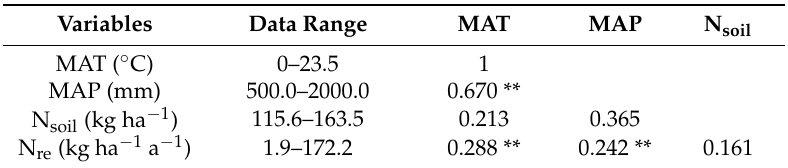
Table 3. Correlation matrix of independent variables. MAT, mean annual temperature; MAP, mean annual precipitation; N soil , soil N content; N re , annual litter N; **, p < 0.01.